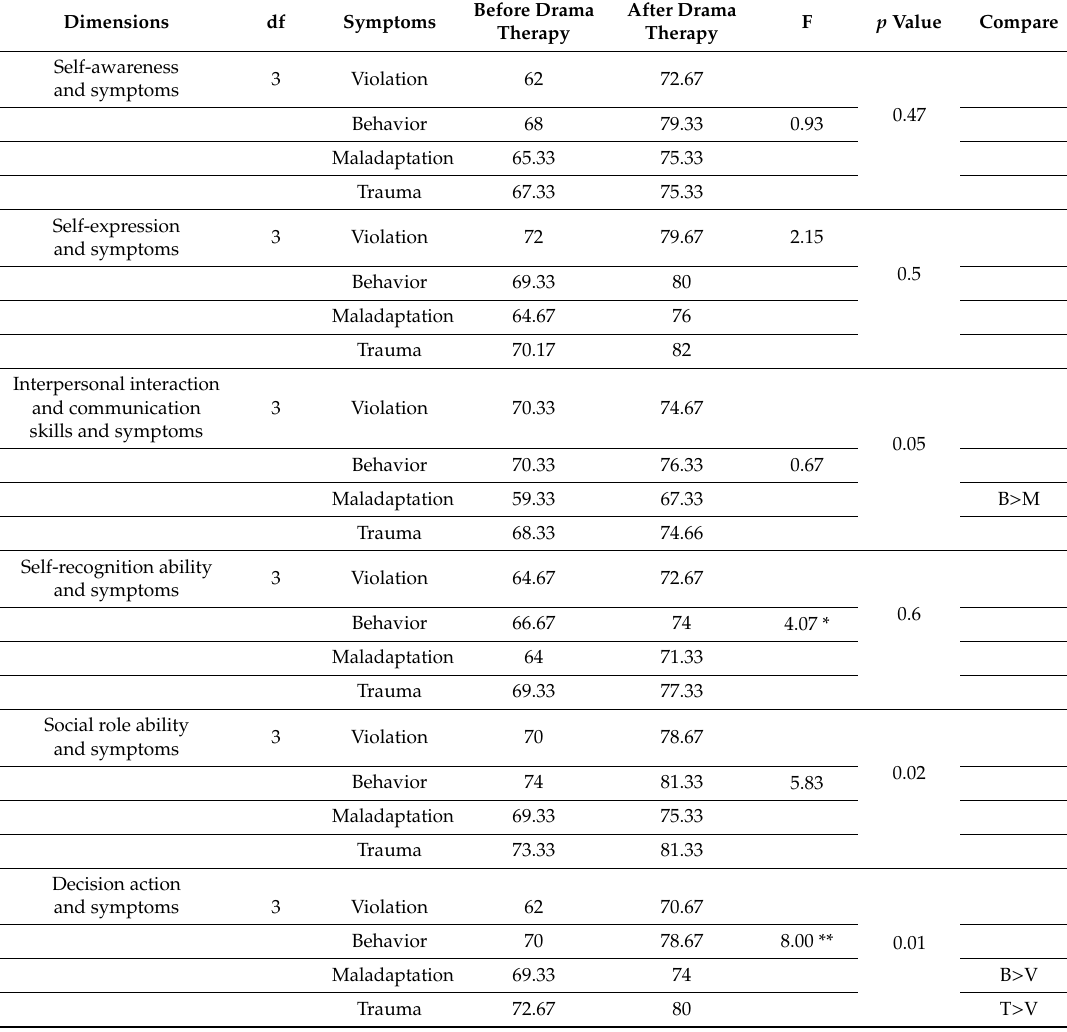
Table 5. Repeated measures ANOVA: The dimensions of evaluations and